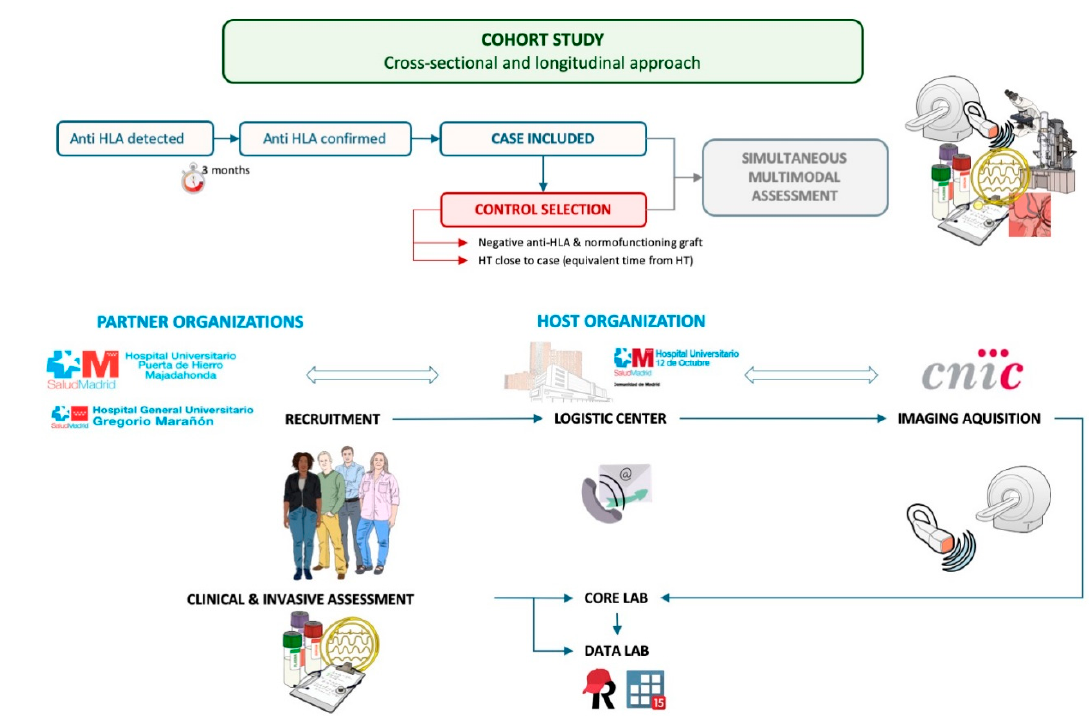
Figure 2. Study design and patient workflow. Table 1. Inclusion and exclusion